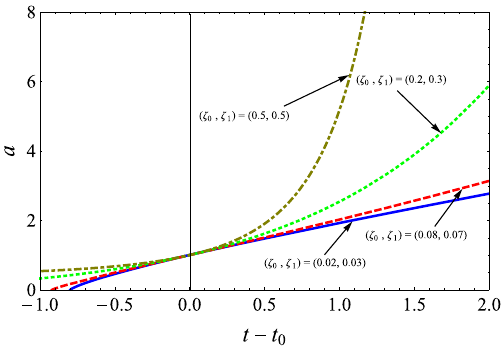
Fig. 6 The plot of the scale factor with respect to t − t 0 for different values of ζ 0 ,ζ 1 when ζ 0 > 0 and ζ 1 > 0 with ω d = − 0 . 5, α = 0 . 8502 and β = 0 .